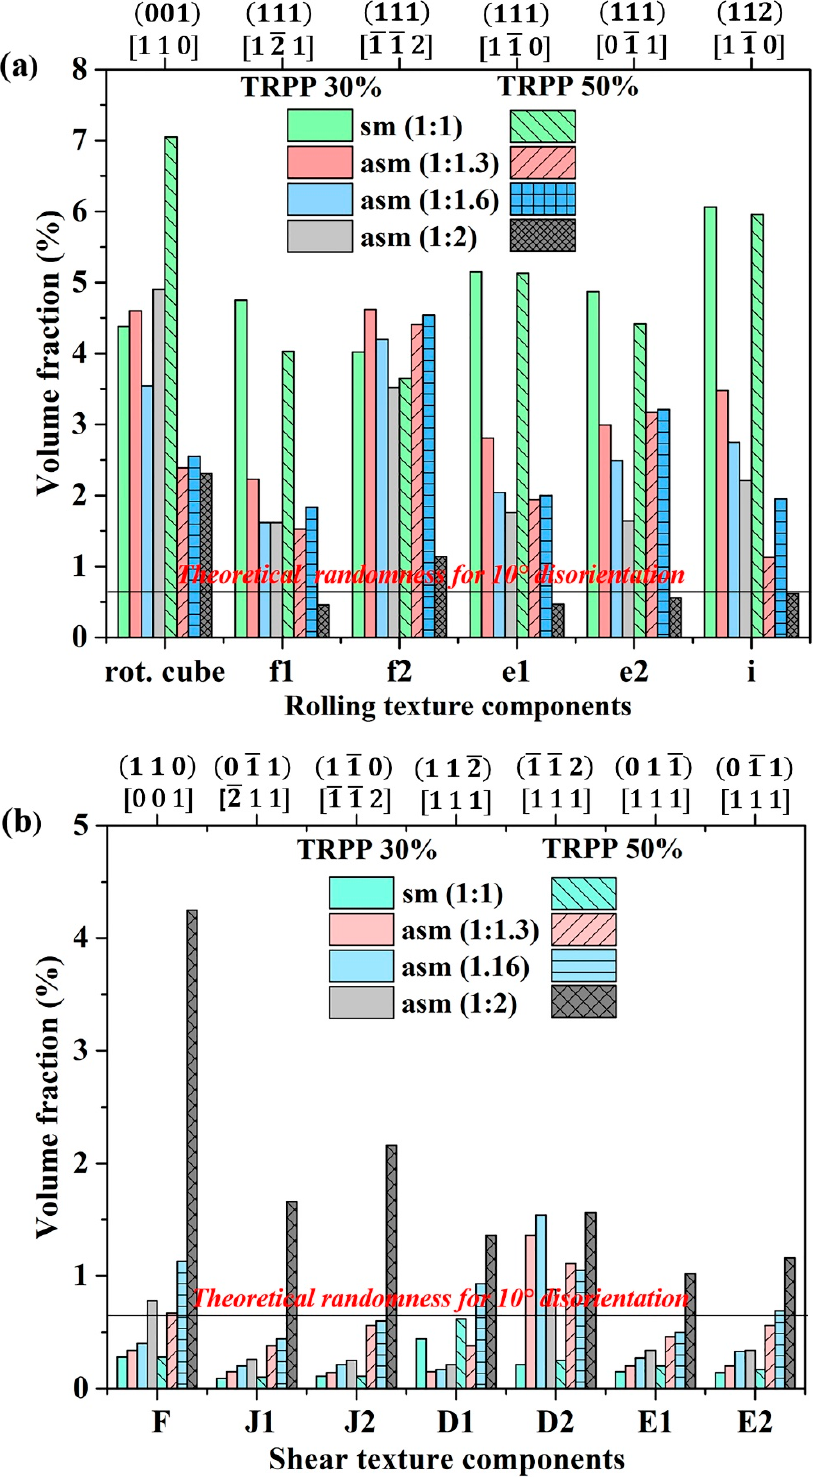
Figure 7. Prominent texture components of ( a ) rolling and ( b ) shear at mid ‐ thickness of the sheet for varying roll diameter ratio from 1:1 to 1:2 at TRPP 30% and 50%.